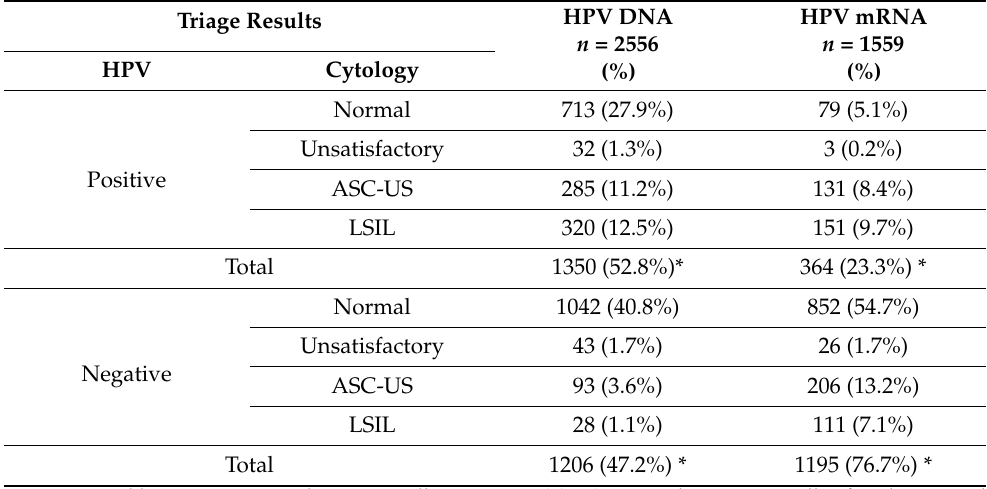
Table 2. HPV and cytology results at triage among HPV DNA-tested and HPV mRNA-tested women. Triage